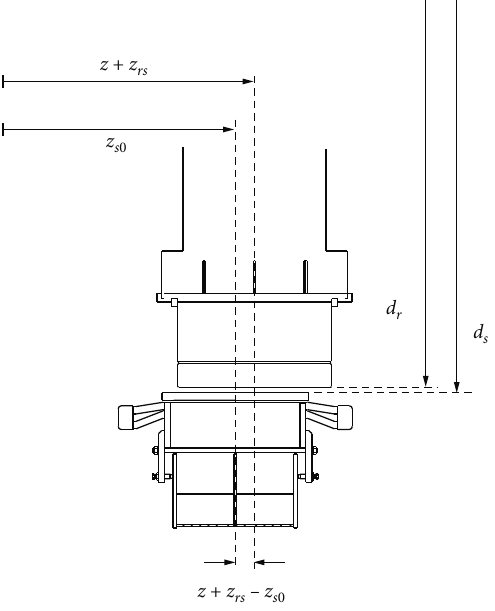
Figure 9: Axial position of stator and rotor magnetic field